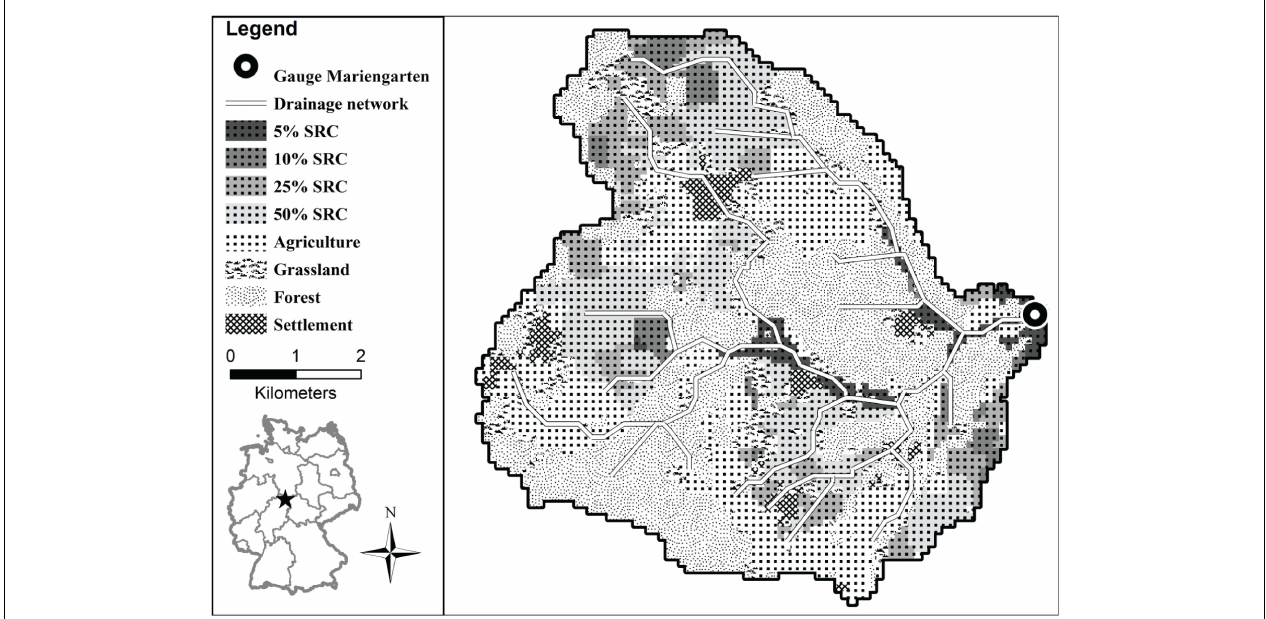
FIGURE 1 | Raster map of the land use composition in the Dramme catchment . Percentages of agricultural area changed to SRC are additive, i.e., 10% SRC includes the 5% SRC areas, etc.